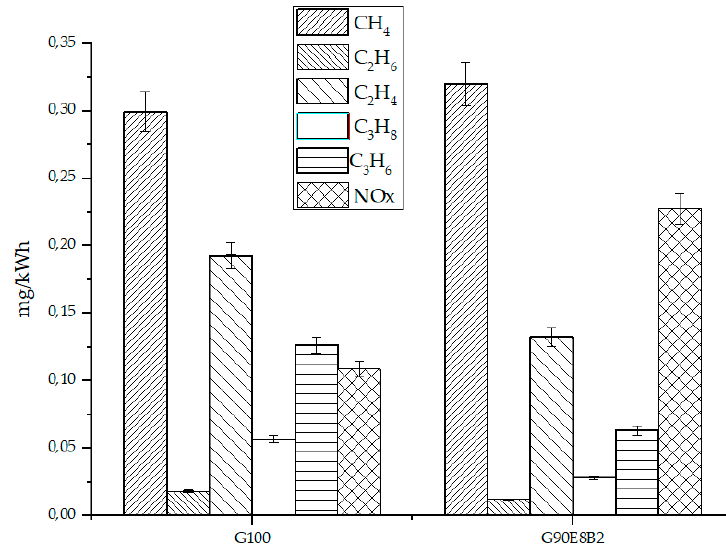
Figure 3. Hydrocarbon and NOx emissions at steady state obtained from the GC analysis.